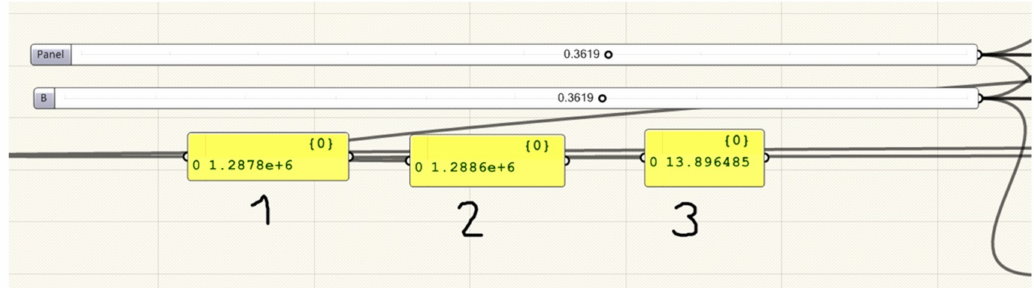
Figure 21. Two sliders and three panels assisting in meeting two conditions for effective fold